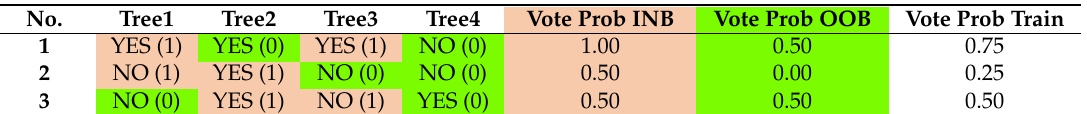
Table 3. Example of Probability matrix and In Bag matrix with estimated probability for each observation based on the majority